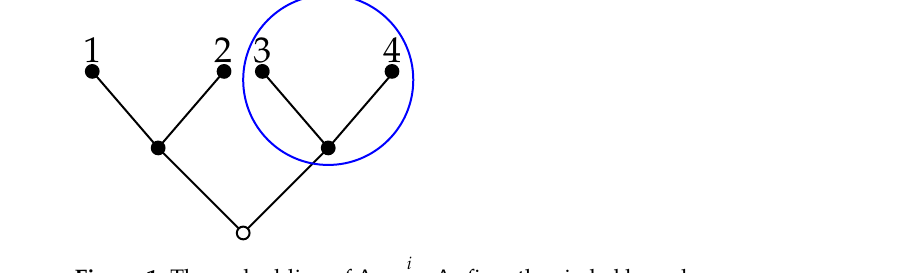
Figure 1. The embedding of A 1